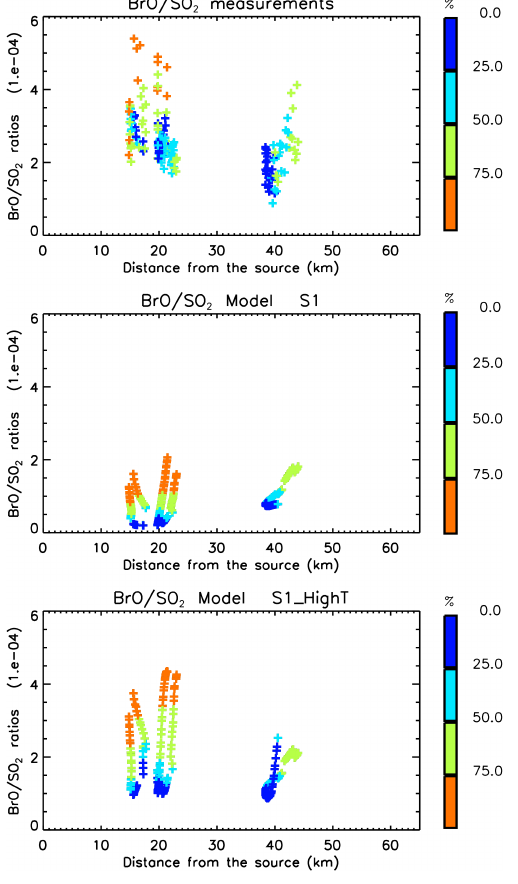
Figure 5. Variation of BrO / SO 2 ratios with distance from the vent derived from observations (top) and model simulations S1 (middle); S1_HighT (bottom) presented in Figs. 3 and 4. For each transect, each BrO / SO 2 ratio has been colored according to its SO 2 column value relative to the maximal value of the SO 2 column (SO2_max) for this transect. More precisely, the color indicates the relative dif- − SO2 ) ference ( SO2_max . Note that we did not include the observa- SO2_max tions nor the corresponding model results for which we did not have GPS data (dashed lines of Figs. 3 and 4).